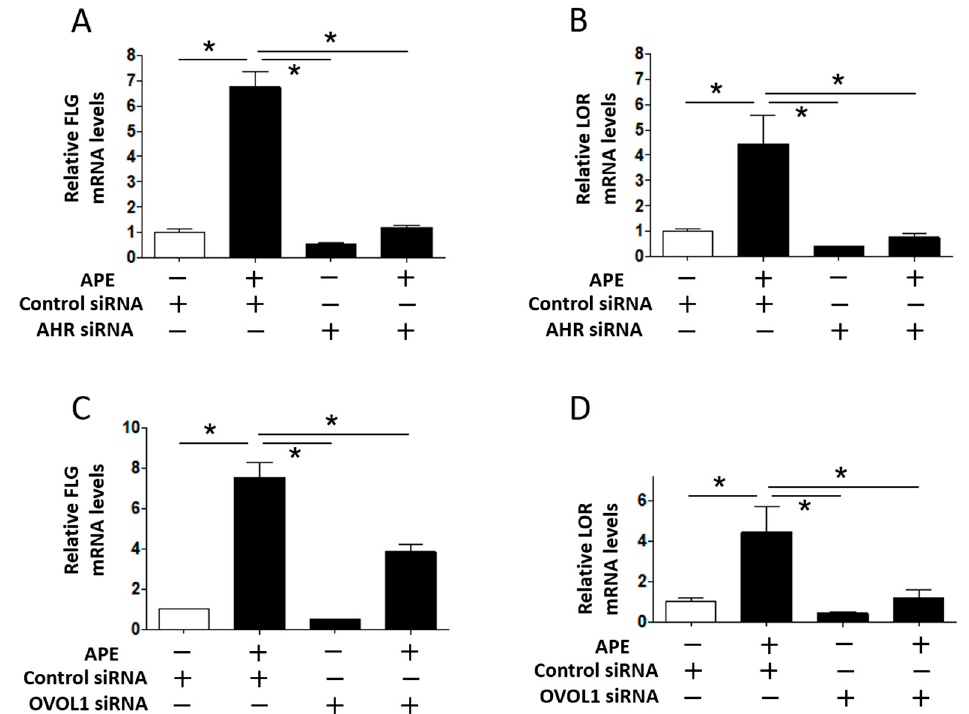
Figure 4. APE (0.03%)-induced FLG ( A ) and LOR ( B ) upregulation is canceled in keratinocytes with AHR knockdown. APE-induced FLG ( C ) and LOR ( D ) upregulation is also inhibited in keratinocytes with OVOL1 knockdown. * p < 0.05.